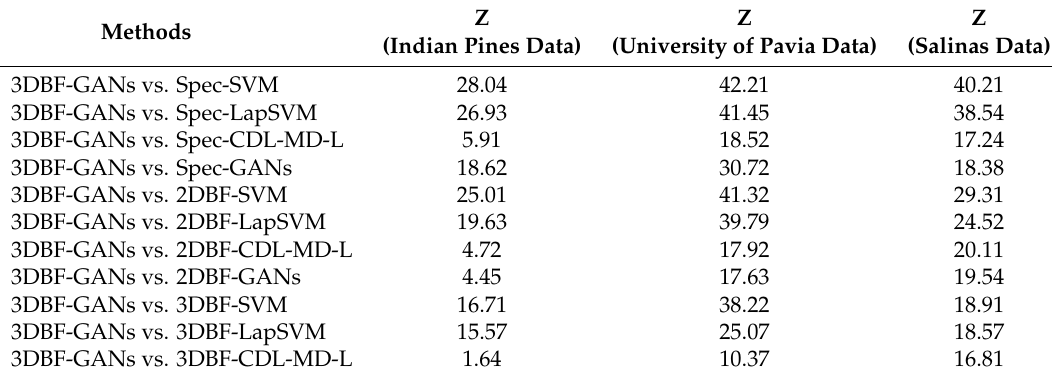
Table 7. McNemar’s test between 3DBF-GANs and other